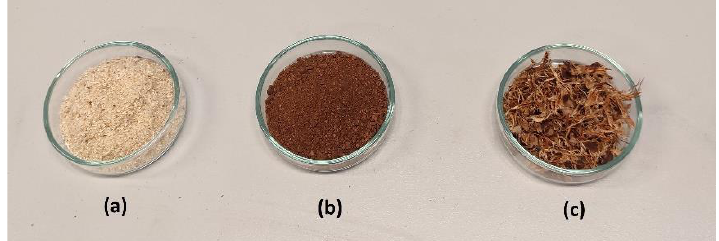
Figure 1. The input materials: ( a ) spruce sawdust; ( b ) spruce bark; ( c ) pine cones. The pellet press operated approximately under the same conditions. There were produced pellets approximately with the same diameter of 6 mm. Then, they were stored for one week at the temperature of 20 ◦ C and relative humidity in the range from 40% to 50%. Produced pellets were created in different proportions, which are shown in Table 1 and Figure